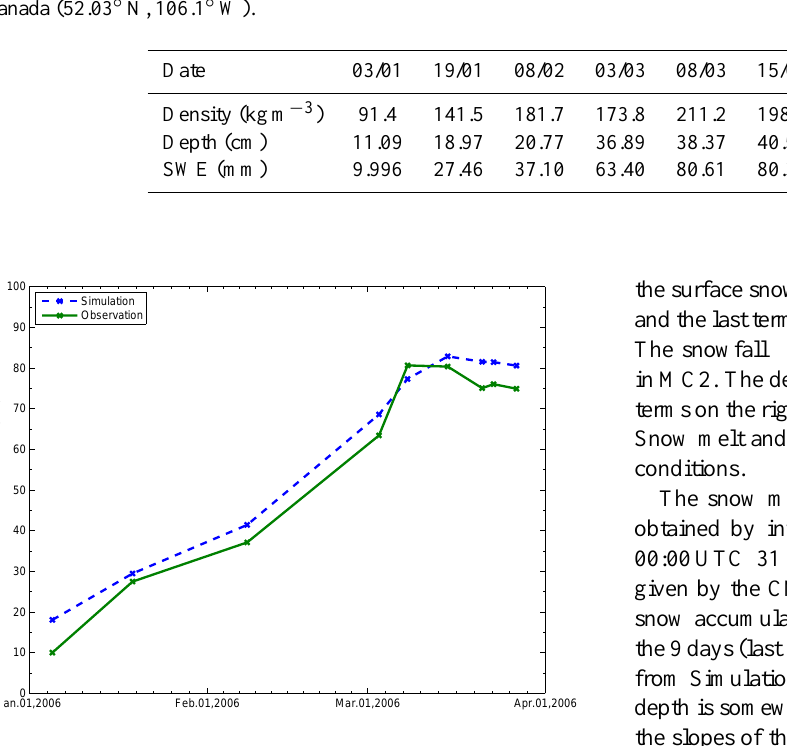
Fig. 3. Comparison of the evolution of observed and simulated pre- melt snow accumulation from January 2005 to April 2006 over SD- NWA. The solid line represents the observation. The simulated pre- melt SWE is obtained by interpolating the grid point values to the station